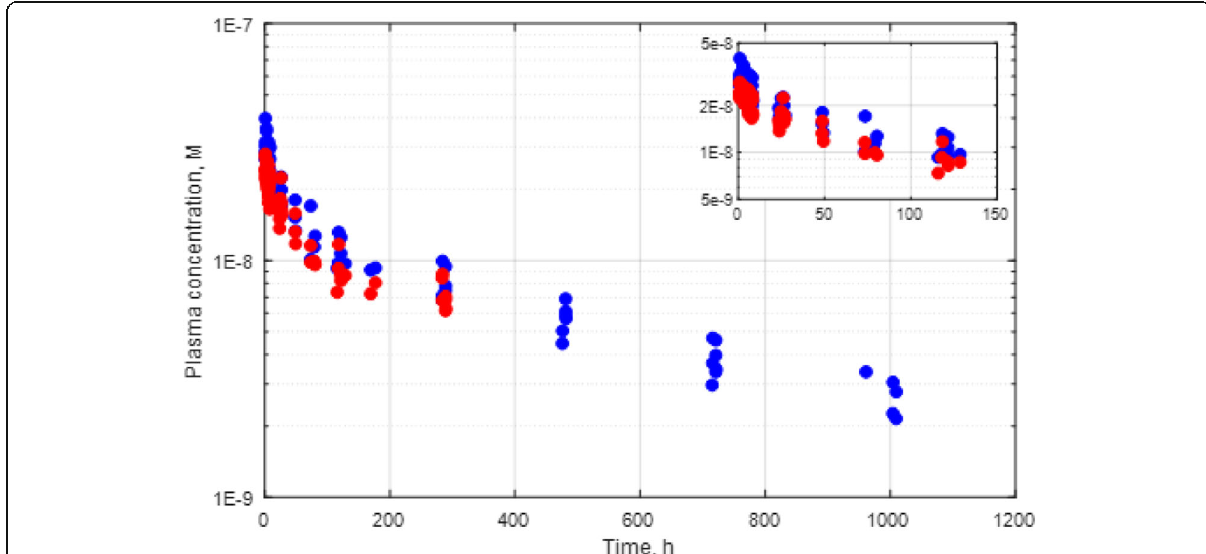
Fig. 4 Plasma PK of [ 89 Zr]-GSK3128349 as detected by radio PK (red circles), and total GSK3128349 as detected by LC/MS (blue circles). Each dot represents data for a single time point from a single subject